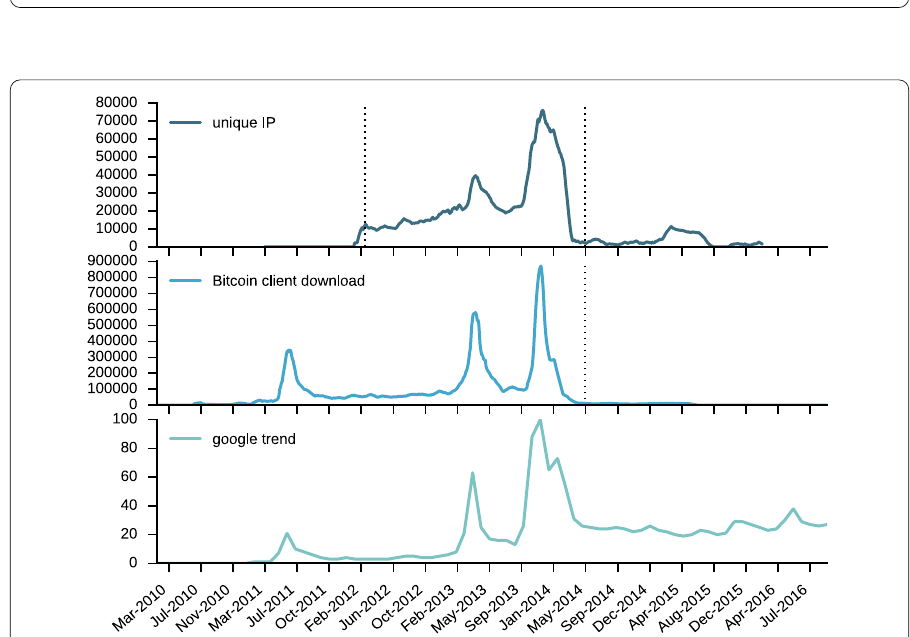
Figure 4 Summary plots of proxies. Time evolution of the number of Bitcoin client downloads, the number of new IP appearing in the Bitcoin system and Google Trends searches on Bitcoin at the worldwide level. The vertical black line marks the limit of database